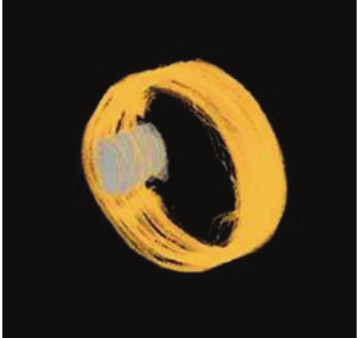
Figure 10: Reconstructed 3D model of the human eye by slice images using